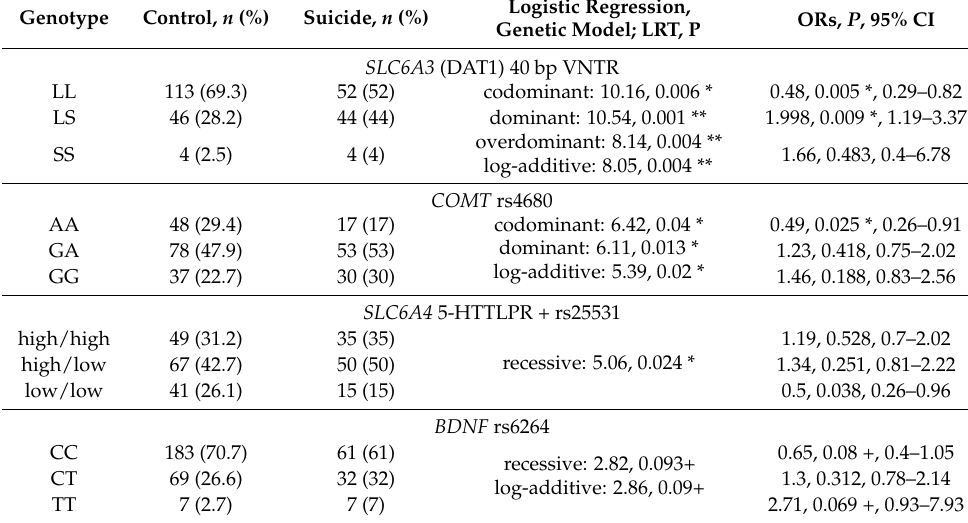
Table 2. Association between genes of dopamine and serotonin systems and suicidal attempts.